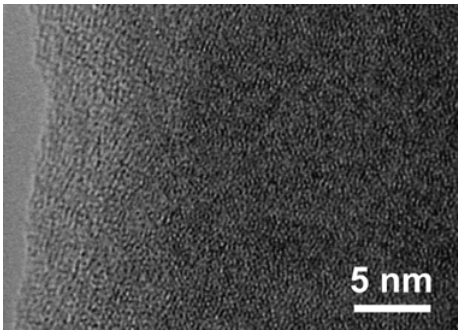
Figure 8. High-resolution TEM image obtained upon in-situ deformation in a